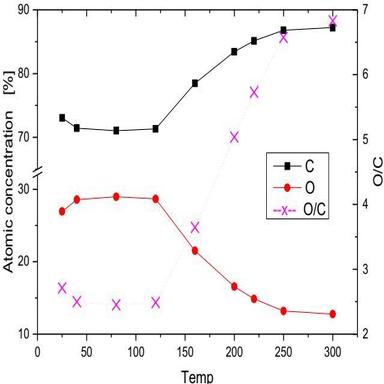
The XPS determined atomic concentration of carbon and oxygen and C/ O ratio for GO annealed at various temperatures.